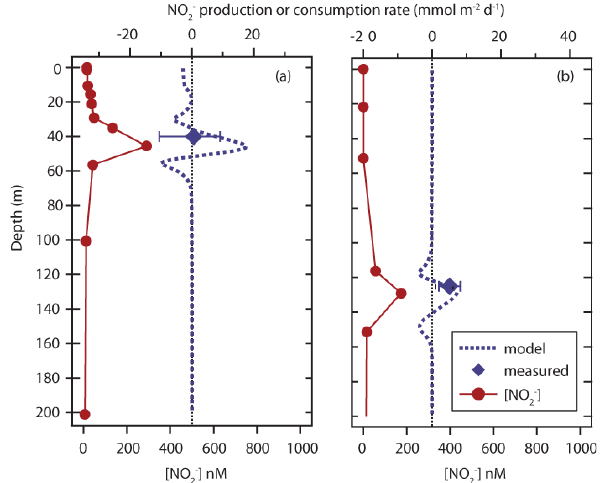
production and loss rates inferred Fig. 5. Vertical profiles of NO − 2 from a 1-D model (blue dashed line) of observed [NO − ] profiles 2 (red circles) at (a) station 67.70 and (b) station 67.155. Measured rates of net NO − production or loss at the PNM are shown as blue 2 diamonds, calculated as described in the text. Model–data compar- isons are only shown for incubations at the PNM due to uncertain- ties in NO − removal above and below the PNM. Error bars reflect 2 total uncertainty in the net NO − production 2